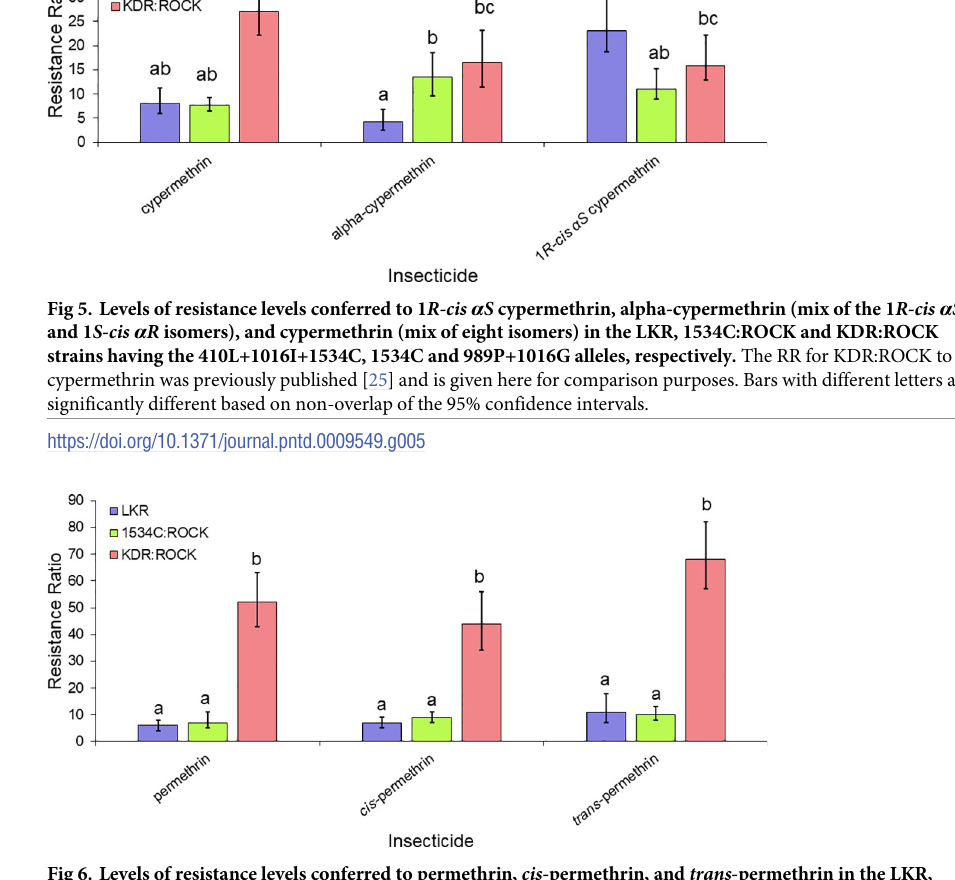
Fig 6. Levels of resistance levels conferred to permethrin, cis- permethrin, and trans -permethrin in the LKR, 1534C:ROCK and KDR:ROCK strains having the 410L+1016I+1534C, 1534C and 989P+1016G alleles, respectively. The RRs for KDR:ROCK to permethrin, cis- permethrin, and trans -permethrin were previously published [25] and given here for comparison purposes. Bars with different letters are significantly different based on non- overlap of the 95% confidence intervals.